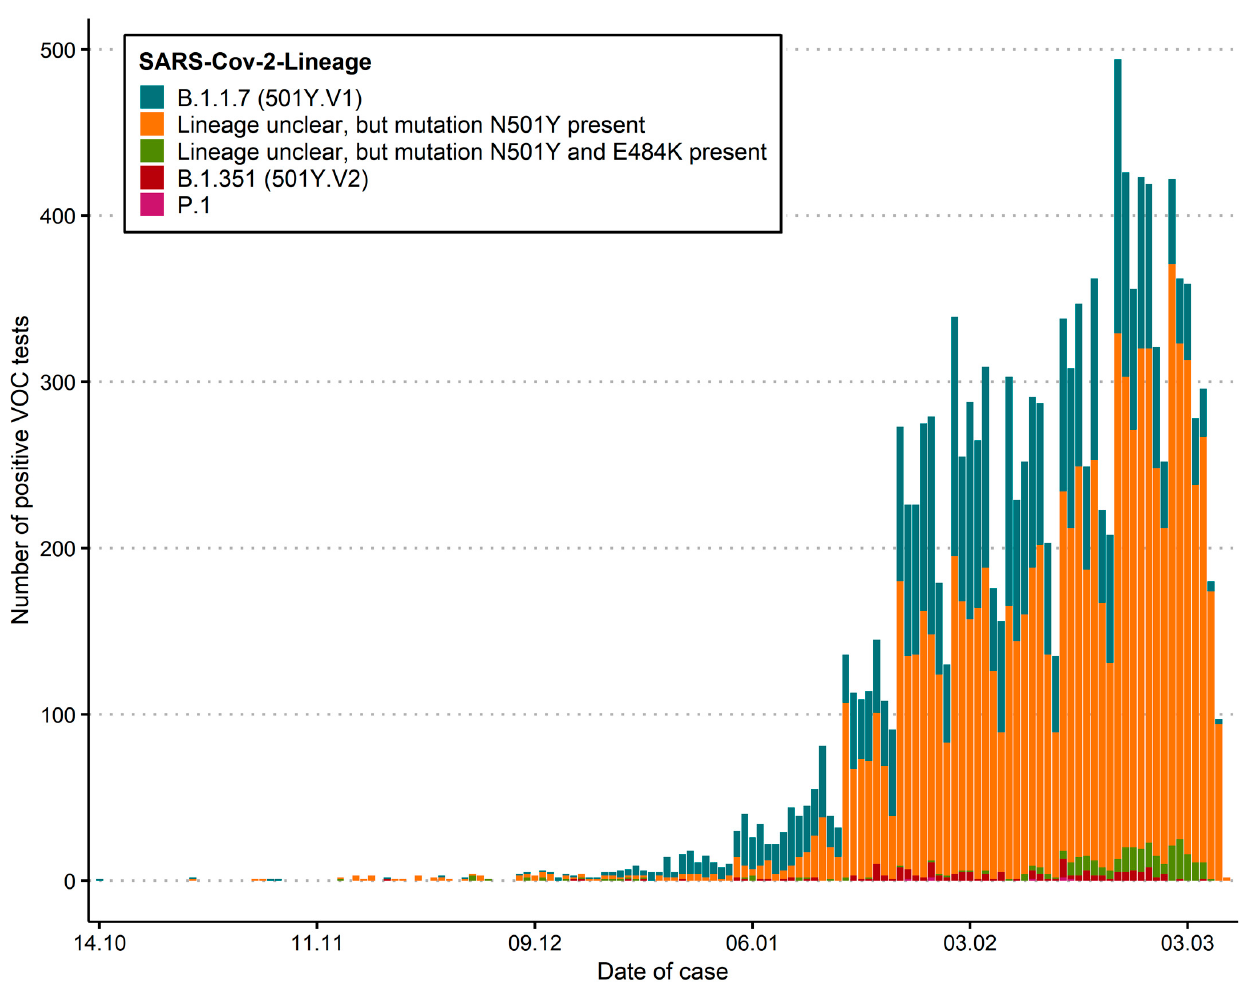
Figure 2. Distribution of absolute numbers as epidemiological curves across Switzerland. solute numbers reflect a biased sample set due to the initial case definitions, higher usage of antigen test in some regions, and distribution of diagnostic capacities. This does not reflect the prevalence of cases. The current number of specific lineages is also biased due to different sequencing capacities. “Lineage unclear” includes isolates which show a N501Y mutation, but where the lineage could not be determined by sequencing, either due to technical difficulties or due to non-availability of the